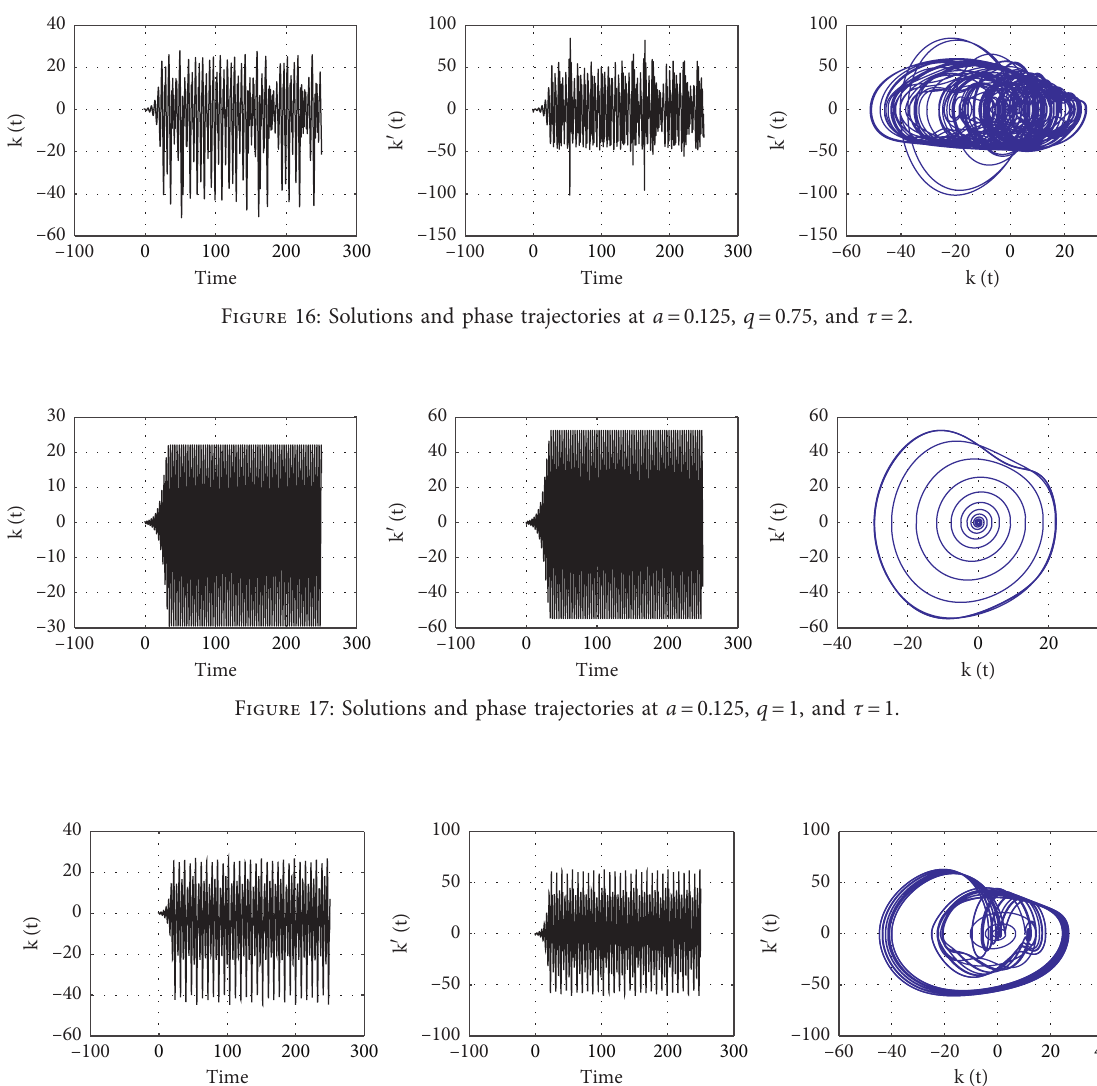
Figure 18: Solutions and phase trajectories at a � 0.125, q � 1, and τ �